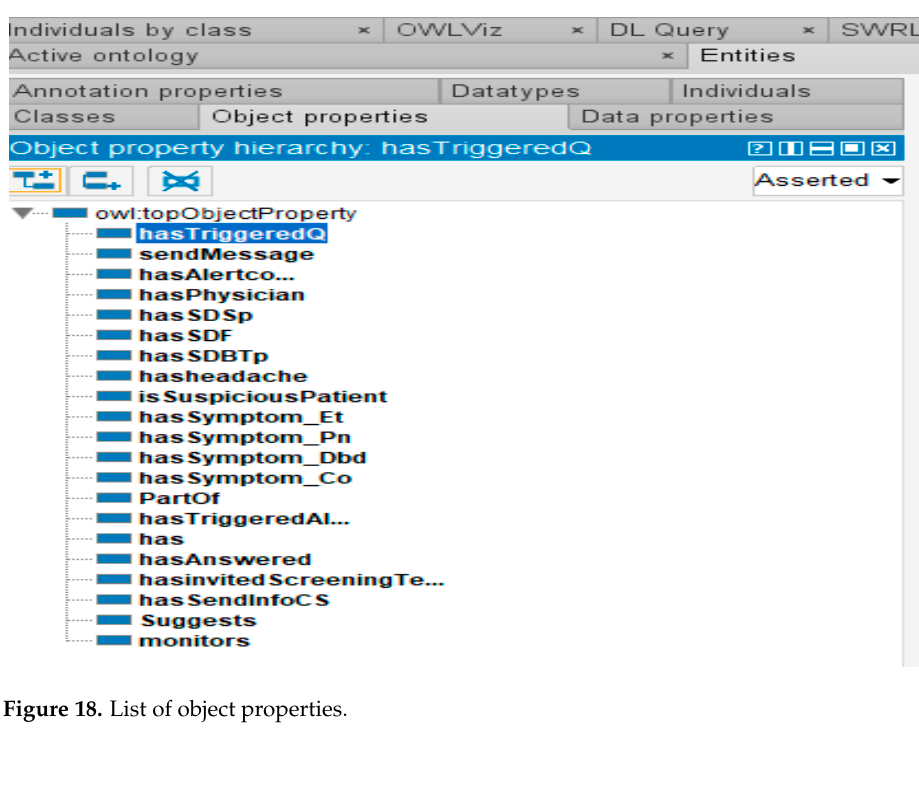
Figure 17. Concepts of system detection.